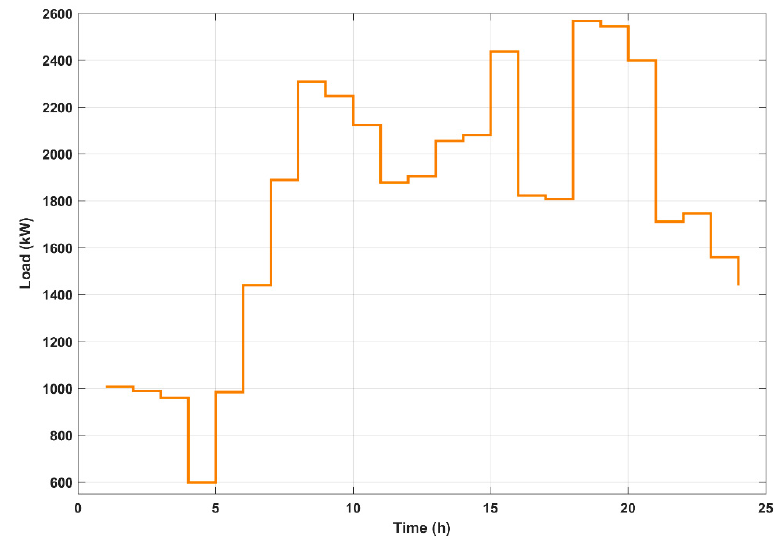
Figure 8. Hourly renewable microgrid load demands under time-of-use (TOU) prices in demand response program (DRP) obtained in Case Study 3. Energies 2020 , 13 , x FOR PEER REVIEW 19 of 25